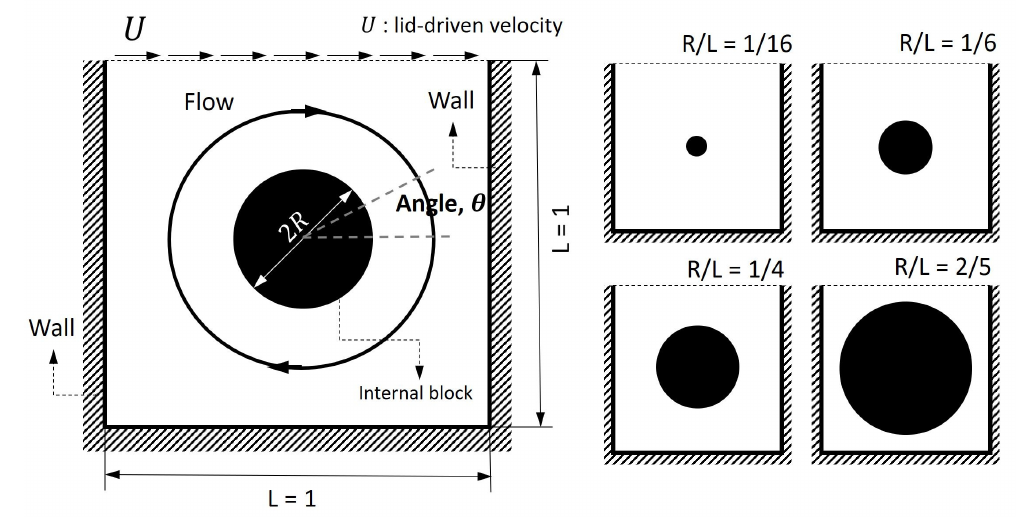
Figure 4. Schematic of lid-driven cavity flow with internal obstacle of various sizes R / L = 1/16, 1/6, 1/4, and